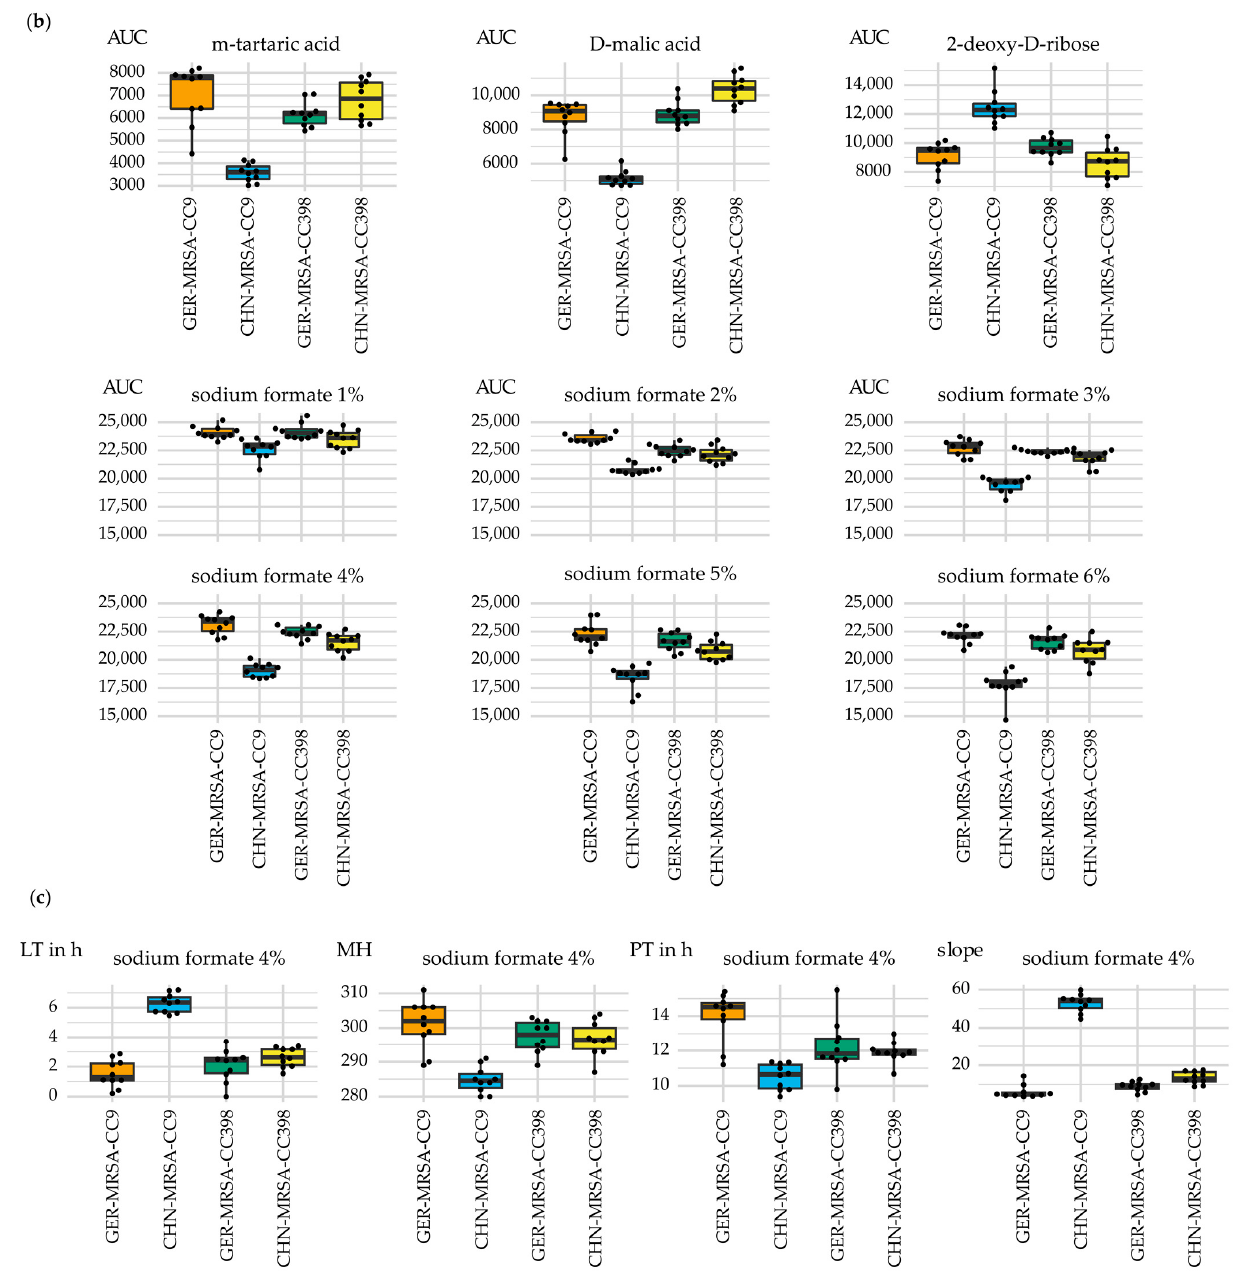
Figure 4. Major differences in the metabolic properties of the CHN-MRSA-CC9 compared with the other three groups regarding the substances or conditions given above the individual charts. The box plots display the varying ( a ) area under the curve (AUC), lag time (LT), maximum height (MH), plateau time (PT) and slope values, ( b ) AUC values and ( c ) LT, MH, PT and slope values of the four isolate groups. LT and PT are given in hours and sodium formate 4% in ( c ) is representative for sodium formate 1% to 6%.